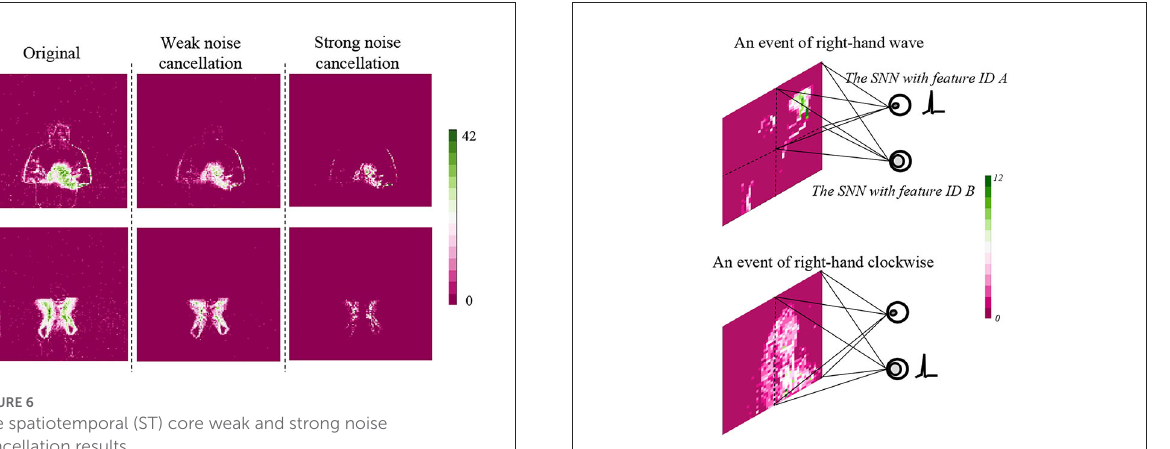
FIGURE7 The spatial SNN with feature indexes A and B results on events of the right-hand wave and right-hand clockwise.